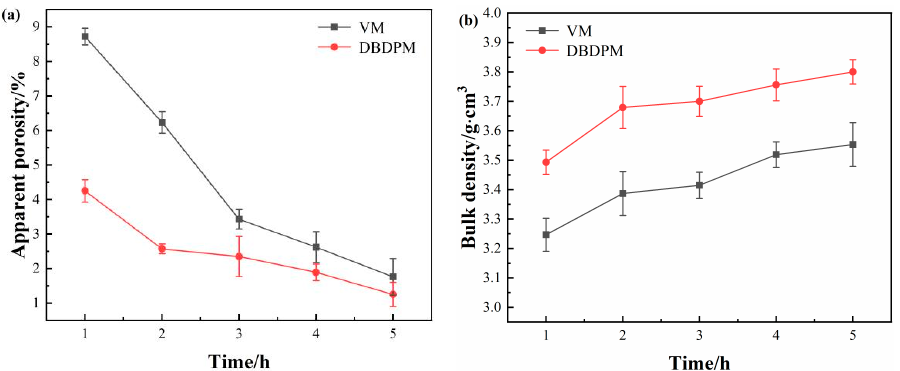
Figure 8. Sintering properties of Al 2 O 3 ceramics fabricated from various alumina powders: ( a ) ap- parent porosity; ( b ) bulk density.